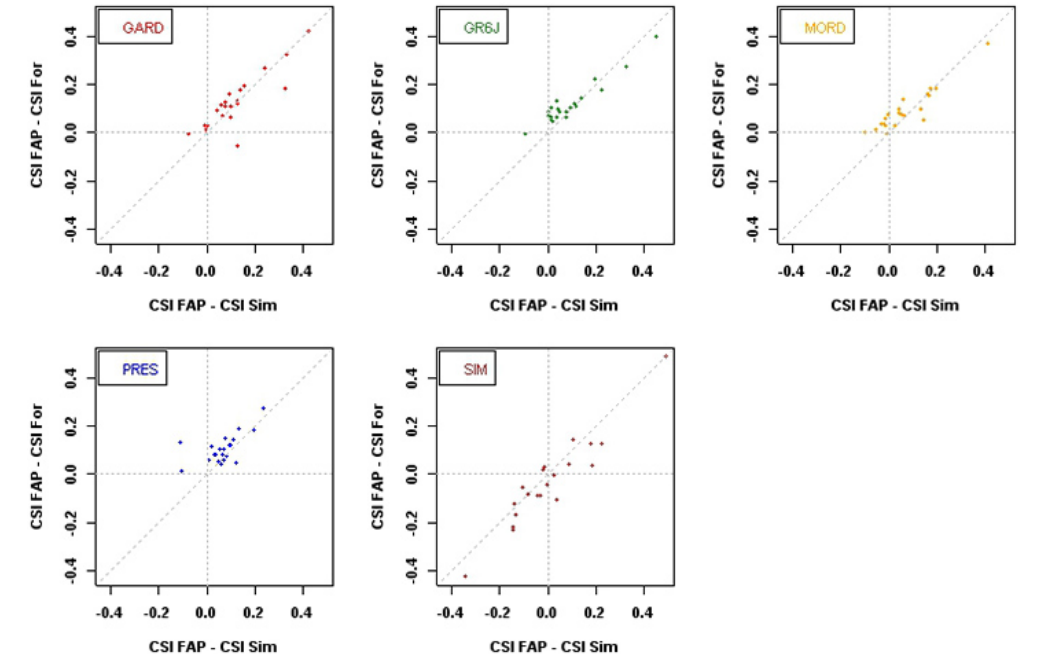
Figure 13. CSI difference for each model in forecasting mode when streamflow assimilation or output correction method is used (FAP) or not (For), versus CSI difference for each model in forecasting mode when streamflow assimilation or output correction method is used (FAP) and in simulation